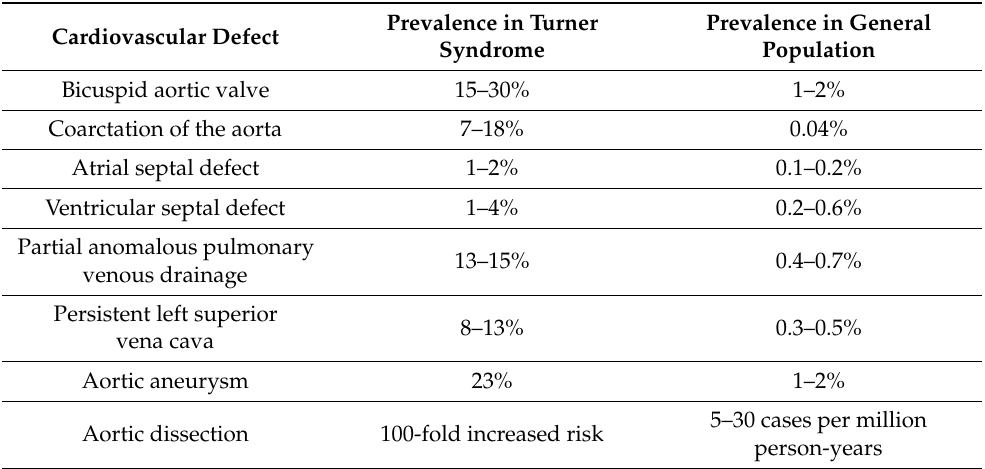
Table 1. Comparison of rates of cardiovascular pathologies in Turner syndrome vs. the general population